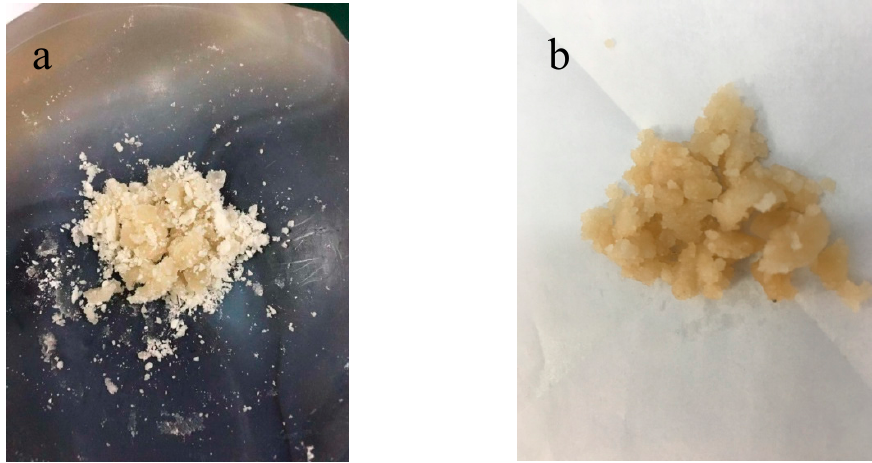
Figure 11. Photographs of the samples ( a ) before and ( b ) after crystallization at 200 °C.